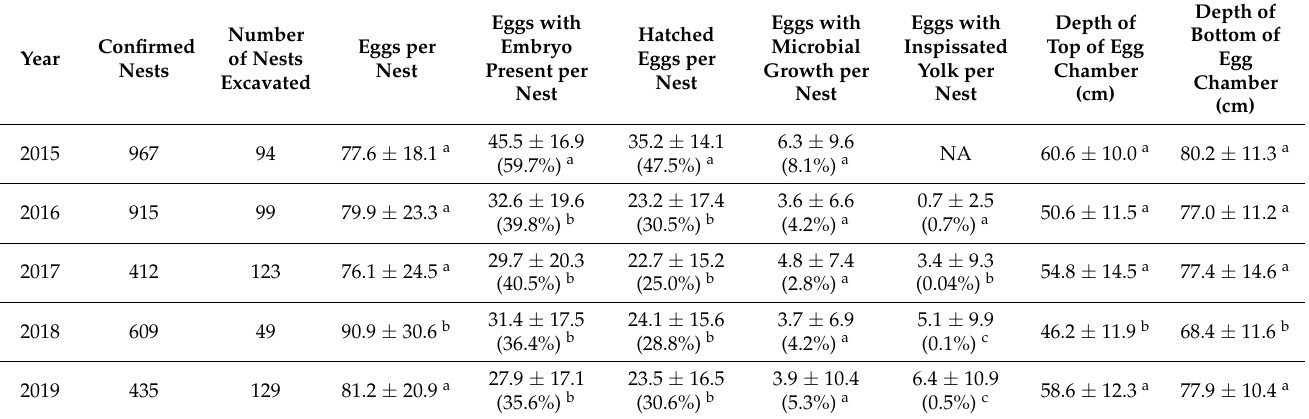
Table 1. Annual leatherback sea turtle ( Dermochelys coriacea ) nesting data from 2015–2019 on Levera Beach, Grenada. Data is represented as mean ± standard deviation (sd) and significant differences between years are designated with a different superscript letter within each